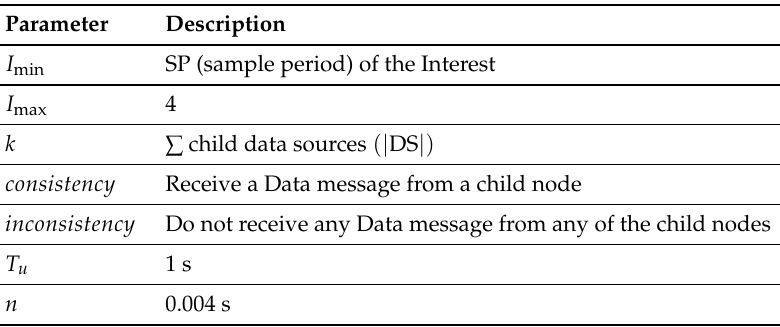
Table 3. Parameters for refreshing interests and updating